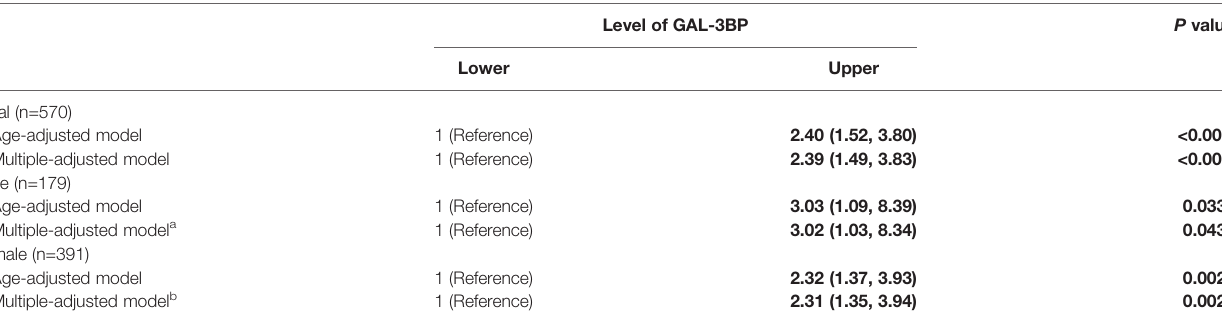
TABLE 2 | Association between Gal-3BP level and MetS.